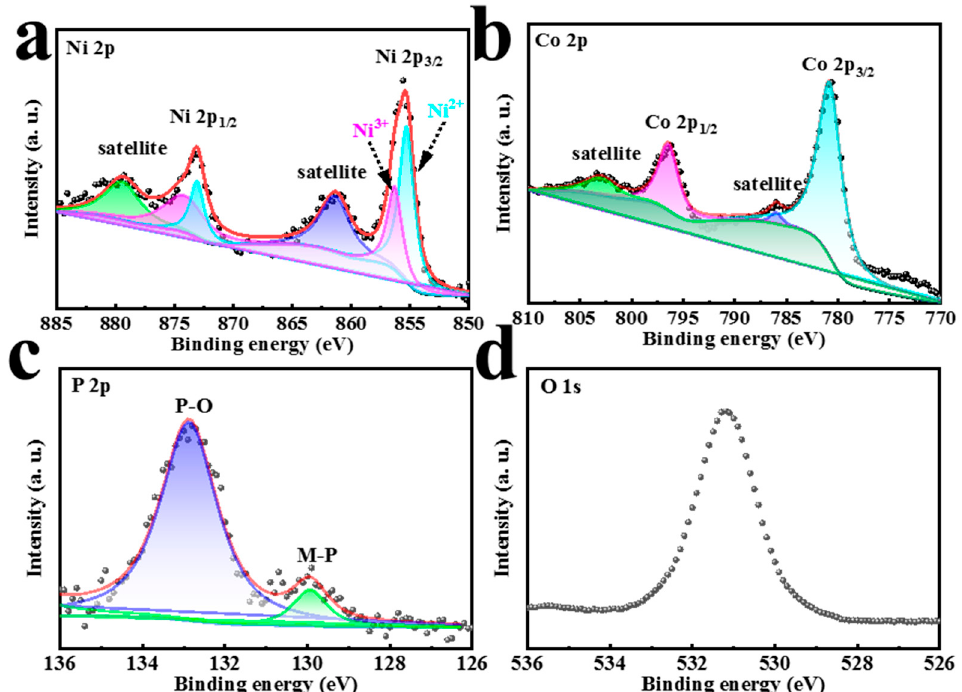
Figure 3. XPS spectra of ( a ) Ni 2p, ( b ) Co 2p, ( c ) P 2p, and ( d ) O 1 s of NiCoP.